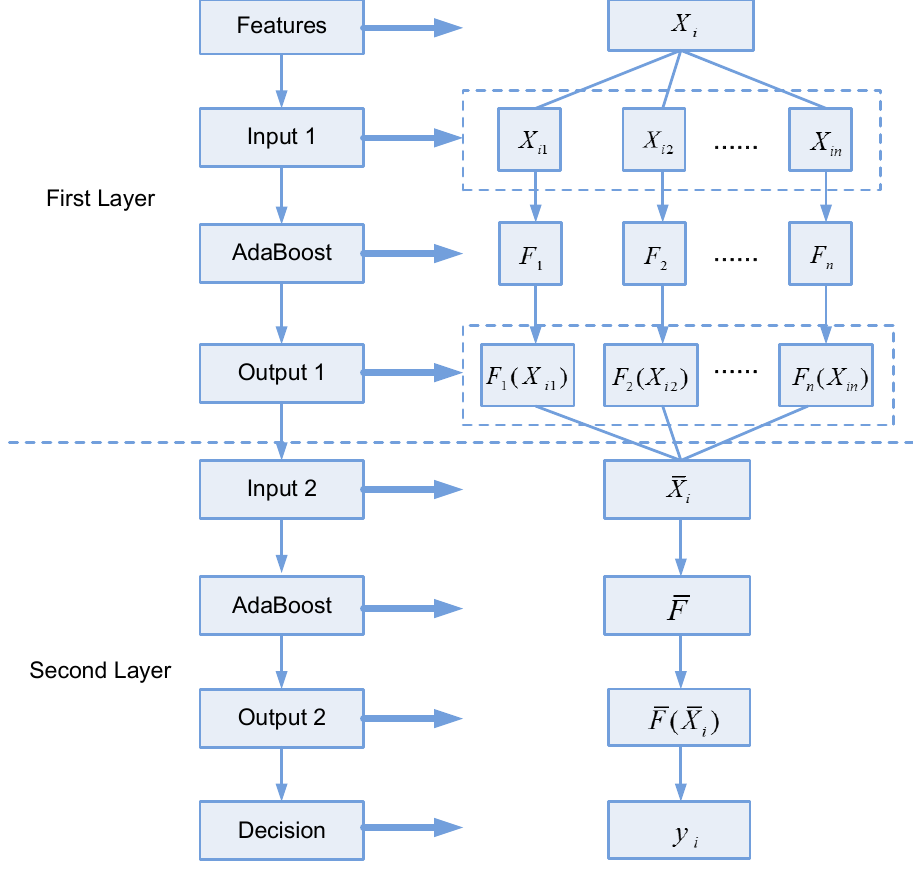
Figure 8. The explanation of two-layer